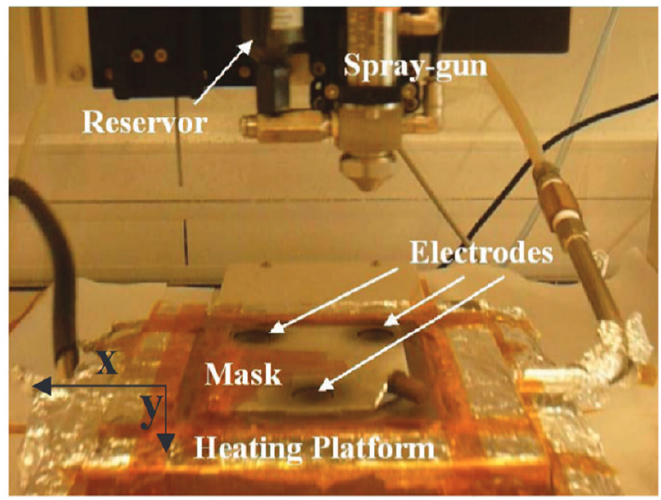
Figure 9. Experimental setup used for the spraying of CNF electrodes on graphite paper collectors with the use of an aluminum mask for circular pattern shaping and a heated substrate to evaporate solvents upon contact [196].